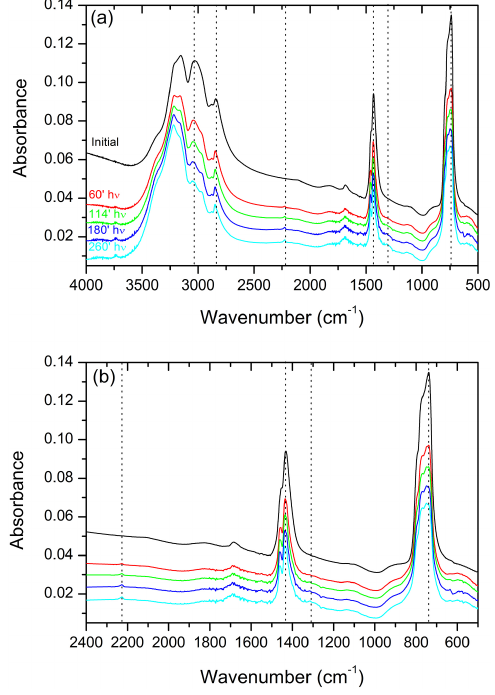
Figure 5. Evolution of the mid-IR transmission spectra of a pure NH 4 IO 3 deposited at 100K during photolysis at that temperature: zero time, 60, 114, 180 and 260min of photolysis in black, red, green, dark and light blue, respectively. Panel (a) shows the whole IR spectra between 4000 and 500cm − 1 ; panel (b) is a zoom-in on the range 2400–600cm − 1 . Dotted lines indicate bands that undergo clear changes during the